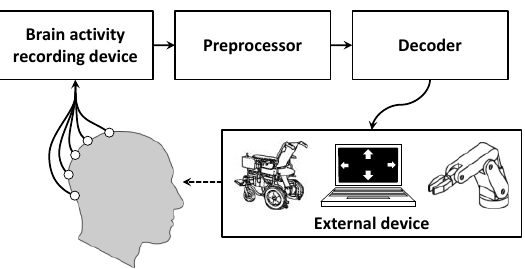
Figure 1. Brain-Computer Interface